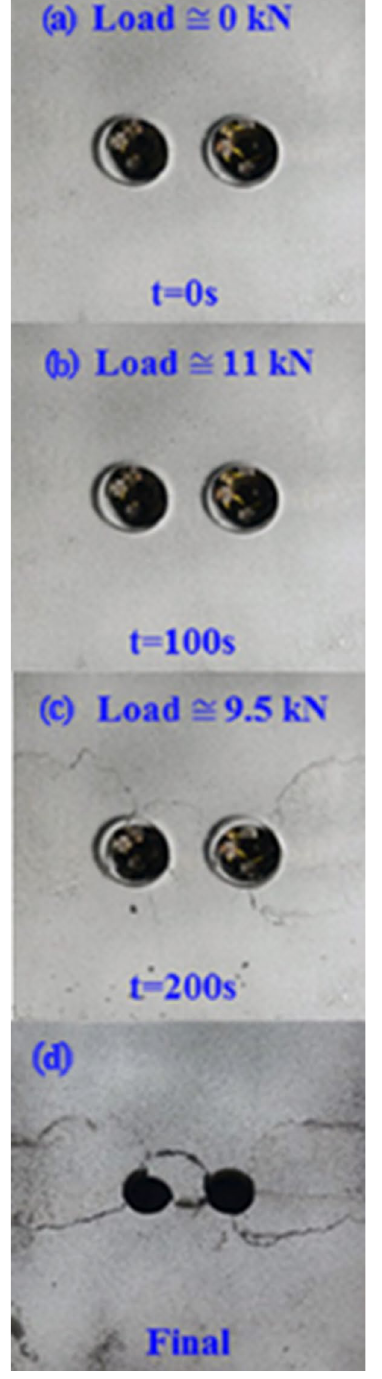
Fig. 15 Crack evolution of 3DP twin tunnels with the same elevation model under the loading process (Jiang et al.